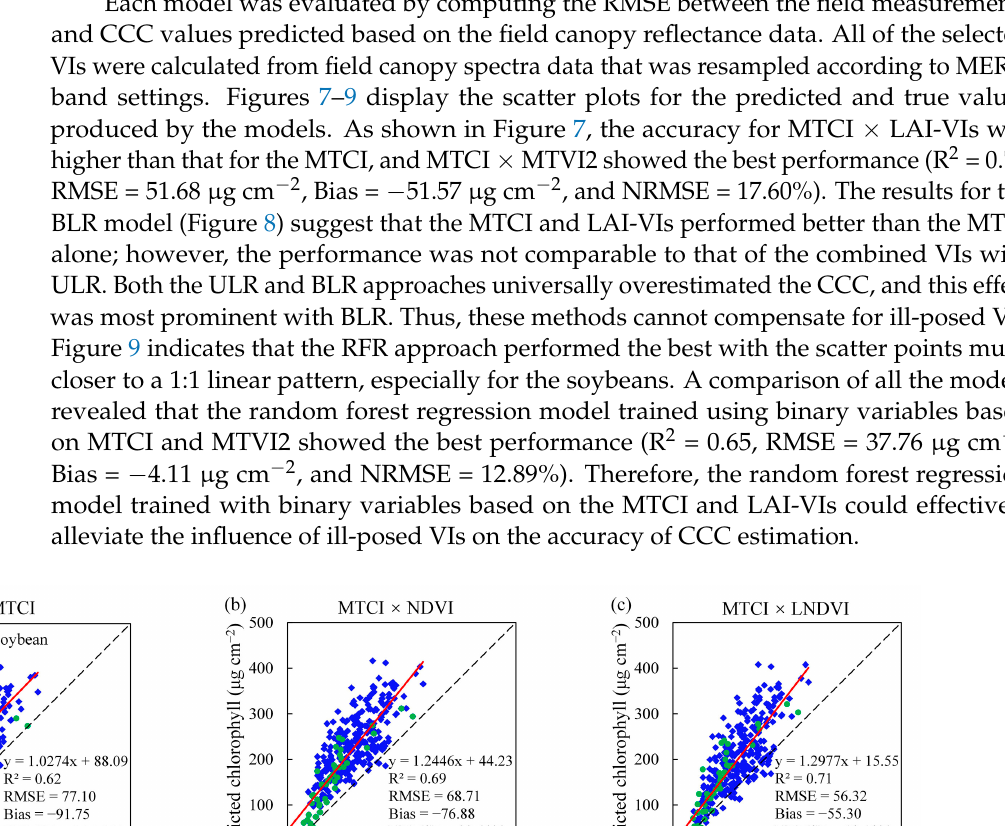
Table 7. Model evaluation for random forest algorithm.